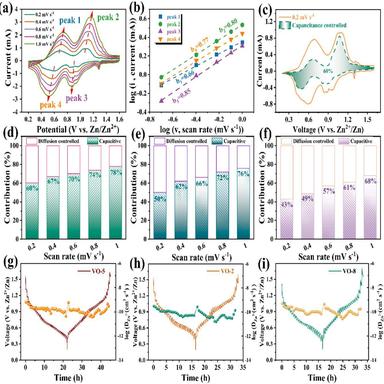
(a) CV curves of VO-5 electrodes at different scan rates. (b) log(i) vs. log(v) plots of VO-5. (c) Capacitive-controlled contribution of VO-5 under 0.2 mV s − 1 . (d–f) Contribution ratios of capacitive-controlled and diffusion-controlled capacities for (d) VO-5, (e) VO-2, and (f) VO-8 under several scan rates. (g-h) GITT curves and diffusion coefficients of (g) VO-5, (h) VO-2, and (i) VO-8 as a function of time.